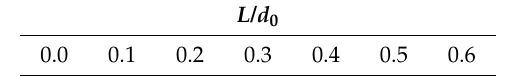
Table 3. Cross-section reductions in the first pass relative to the total reduction ( R A / R T ). R A / R T Table 4. Non-dimensional length ( L / d 0 ) in extrusions with double-pass dies. L / d 0